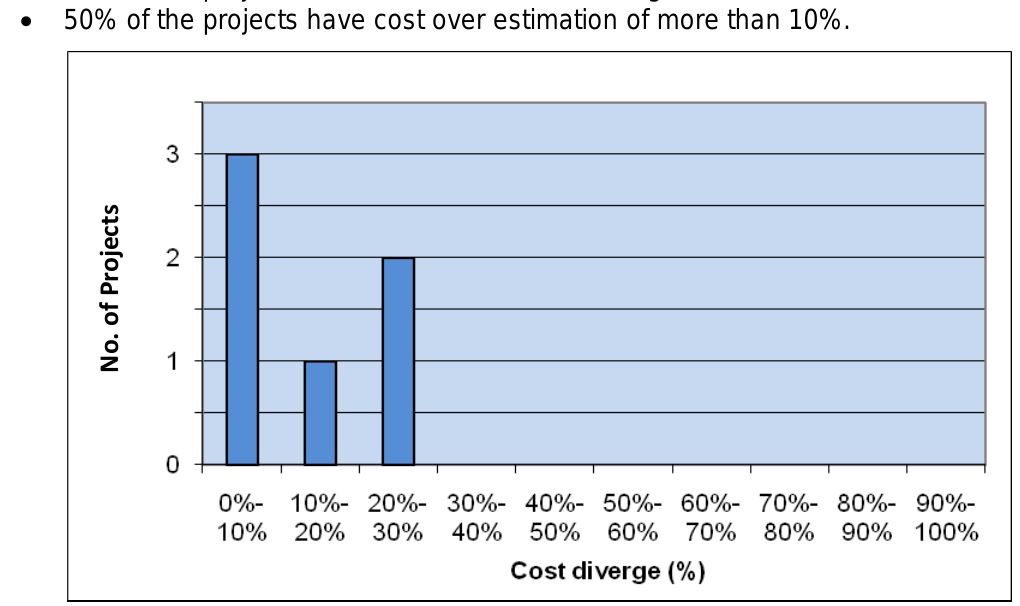
Figure 6 Cost over-estimates vs. no of projects for small road construction projects